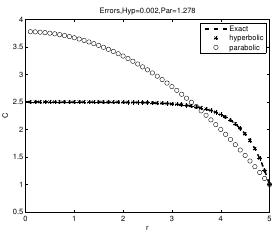
Figure 1. Solution of the model equations